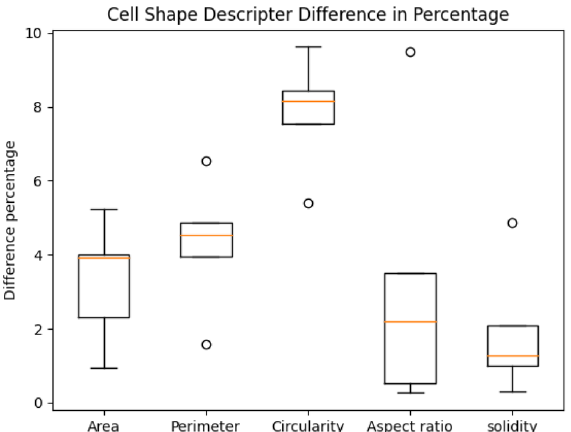
Figure 7. 3D segmentation evaluation using cell shape descriptors including area, perimeter, circularity, aspect ratio, and solidity (ratio between cell area and its convex hull area). The difference is in terms of